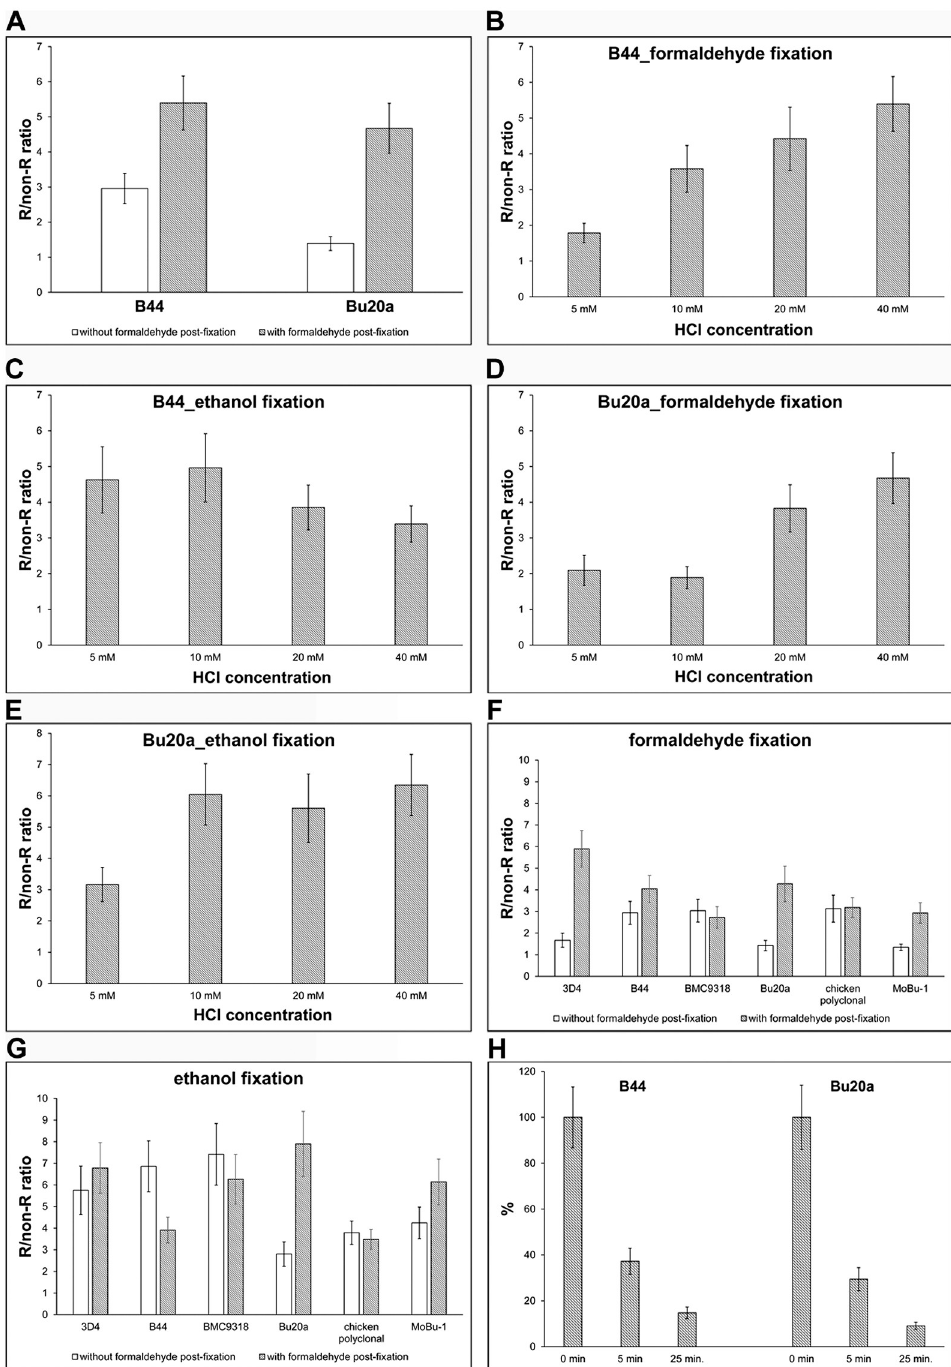
Fig 1. Optimising the protocol for BrdU detection. (A) HeLa cells were incubatedwith BrdU for 30 min, fixed with formaldehyde and BrdU was detected in DNA using 40 mM HCl. BrdU was detected either by the B44 or Bu20a anti-BrdUantibody with exonuclease III. The effect of formaldehyde post-fixation on the signal is shown as well. The data are presentedas the mean ± SD. ( B-E) A comparison of various HCl concentrations on BrdU signalin HeLa cells labelledfor 30 min with BrdU and fixed either with formaldehyde (B, D) or ethanol(C, E). The incorporated BrdU was detected using either B44 (B, C) or Bu20a (D, E) antibody clone with exonuclease III. The data are presentedas the mean ± SD. ( F, G) A comparisonof five monoclonal anti-BrdU antibody clones and one polyclonalantibody is shown. The HeLa cells were labelledwith BrdU for 30 min and fixed either with